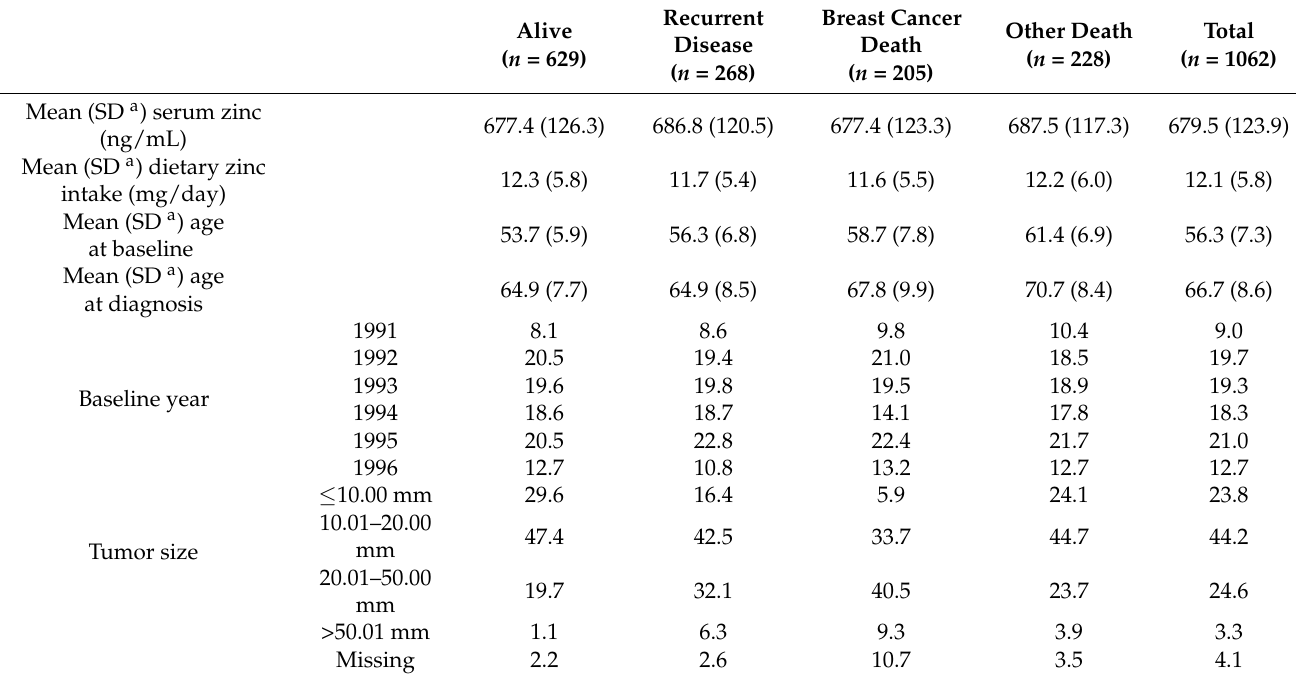
Table 1. Vital status and prognostic factors. All data are presented as column percentage, except for mean serum zinc, zinc intake and age. Missing data <1% are not shown. Recurrent Breast Alive Disease ( n = 629) ( n = 268)